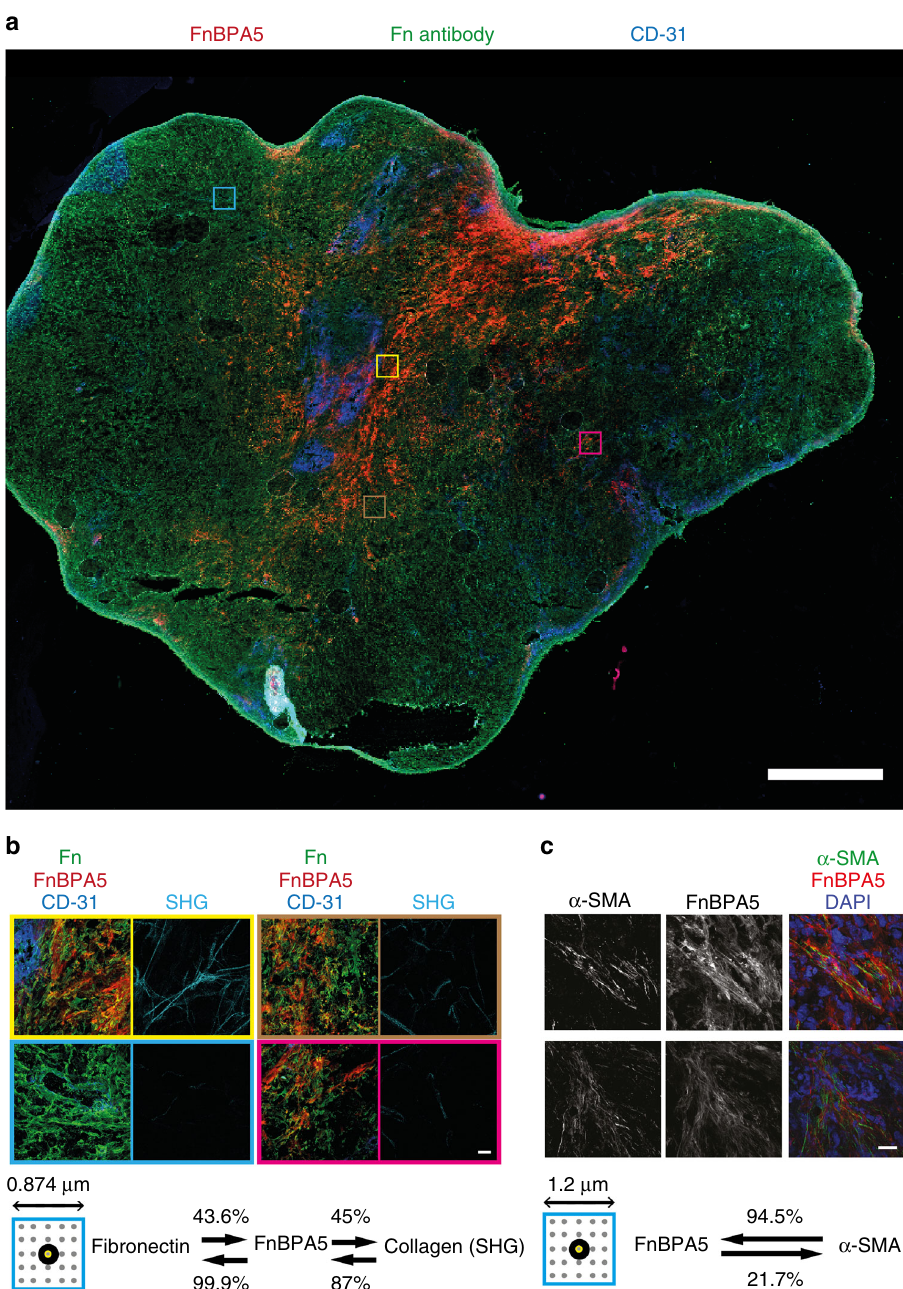
Fig. 4 Post mortem tumor cryosection from prostate cancer (PC-3) xenografts. a Overview mosaic image of a whole PC-3 tumor tissue section co-stained with the peptide FnBPA5 Alexa-488 (red), together with polyclonal antibodies against Fn (green) and endothelial cell marker CD-31 (PECAM-1) (blue). Scale bar, 1 mm b Zoomed-in high-resolution z-projection images of different indicated regions showing superpositions of the stains FnBPA5 (red), fi bronectin (green), and CD-31 (blue), as well as the mature collagen fi bers in the same regions as visualized by SHG (cyan). Analysis of neighboring pixels (indicated by the small box showing the 5 × 5 pixel matrix surrounding each analyzed pixel) between antibody-stained Fn, FnBPA5 peptide and collagen bundles (SHG) showed a clear spatial proximity of FnBPA5 with Fn (99.9% of all FnBPA5 pixels have at least one neighboring Fn pixel). A total of 87% of pixels from mature collagen bundles were found to be in close proximity (within the 5 × 5 matrix of neighboring pixels) of FnBPA5-positive pixels (19 images analyzed). Scale bar, 20 μ m. c Representative z-projection images of PC-3 tumor tissue sections stained for α -SMA and FnBPA5 and merged with nuclei stainings using DAPI. Analysis of neighboring pixels (indicated by the small box showing the 5 × 5 pixel matrix surrounding each analyzed pixel) reveals that 94% of the α -SMA-positive pixels are in close proximity (within the 5 × 5 matrix of neighboring pixels) to FnBPA5-positive regions (60 images analyzed). Lower thresholds were set based on individual channels to exclude unspeci fi c pixels from the analysis, and a 5 × 5 matrix was used for the spatial proximity analysis of each pixel in 60 images, respectively, with each of the analyzed pixels being in the center (Methods section for more details). Scale bar, 20 μ